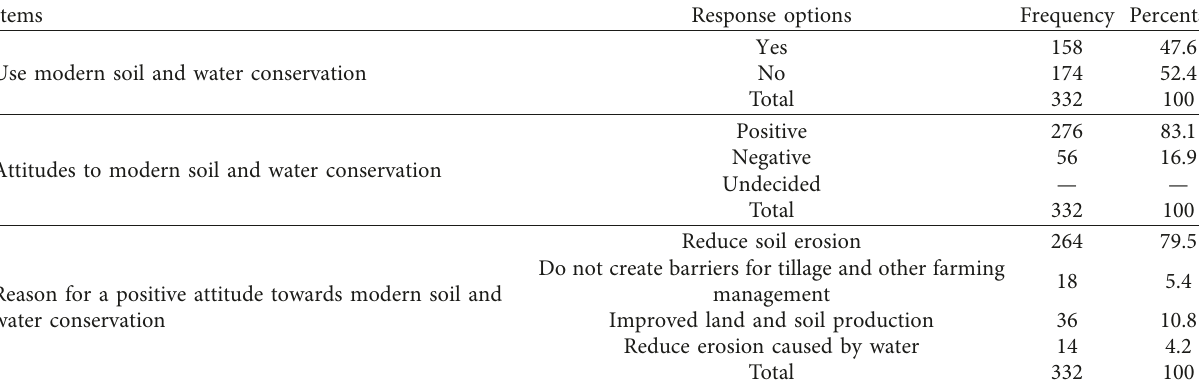
Table 8: Farmers’ opinions and attitudes regarding contemporary water and soil conservation techniques.